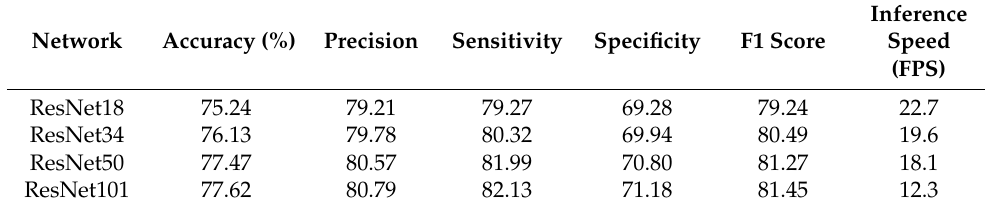
Table 9. Effects of different activation functions and optimizers on test accuracy.